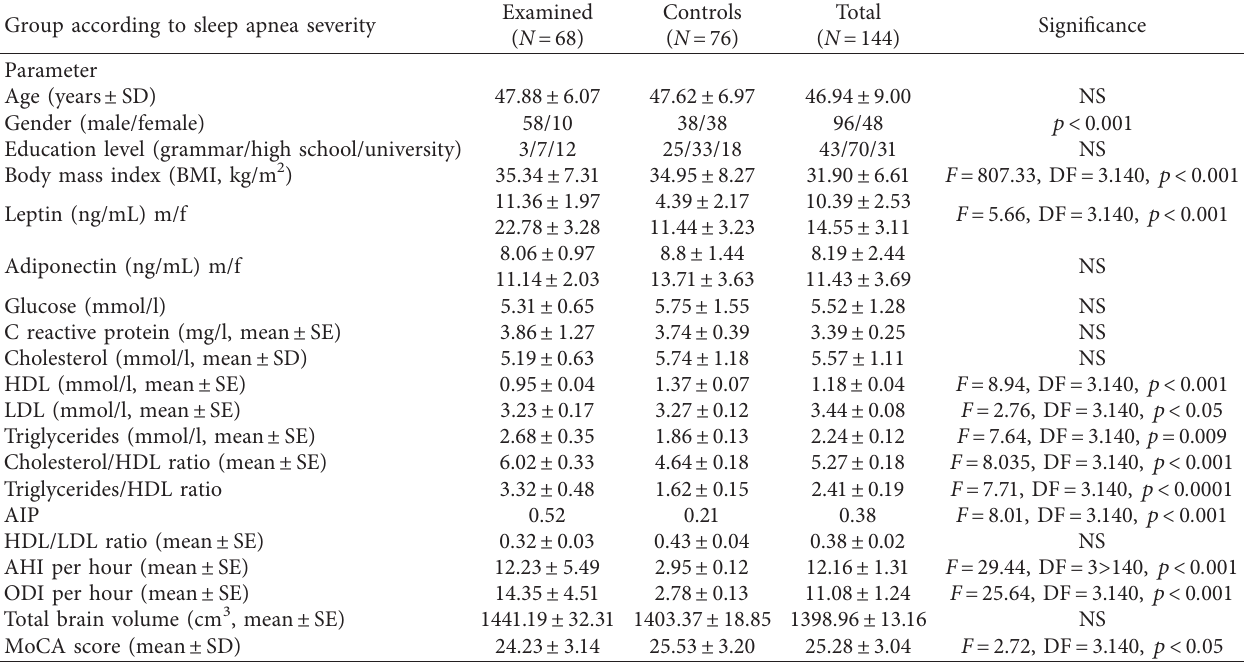
Table 1: Demographic parameters of examined